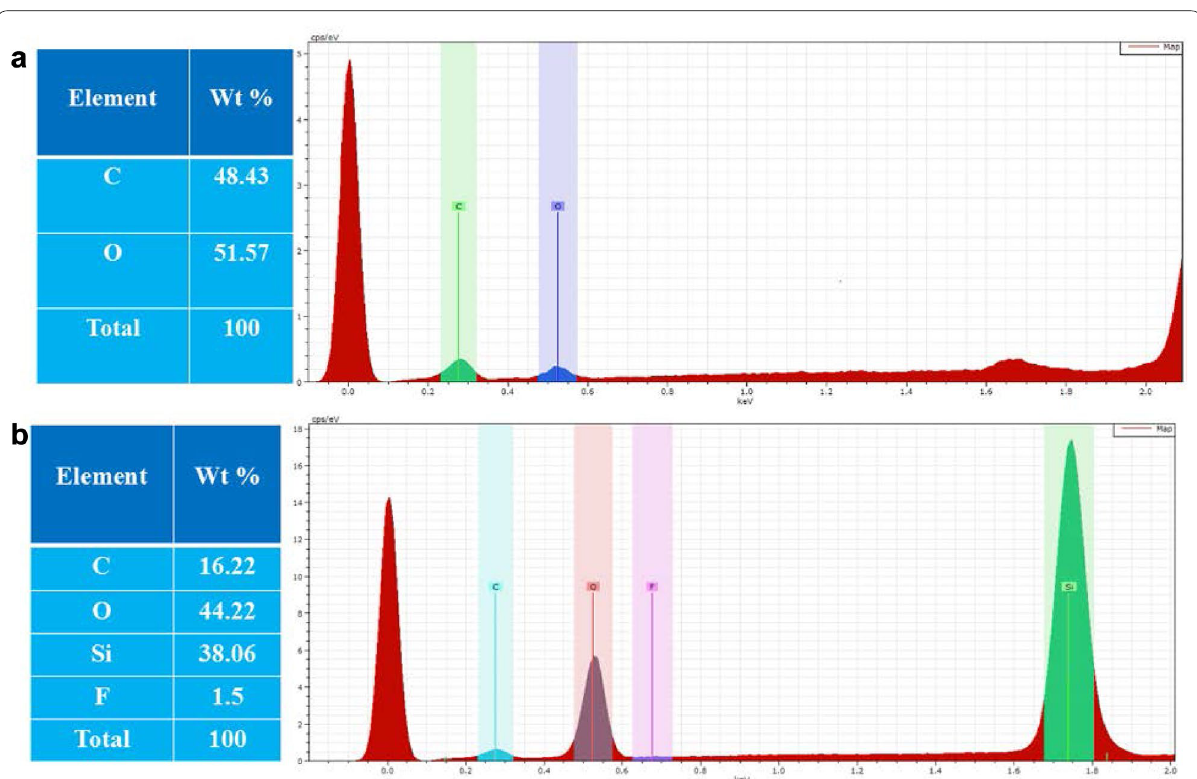
Fig. 6 The wt% of each element and EDX spectra of pristine corn straw fiber ( a ) and the prepared superhydrophobic/superoleophilic corn straw fiber ( b